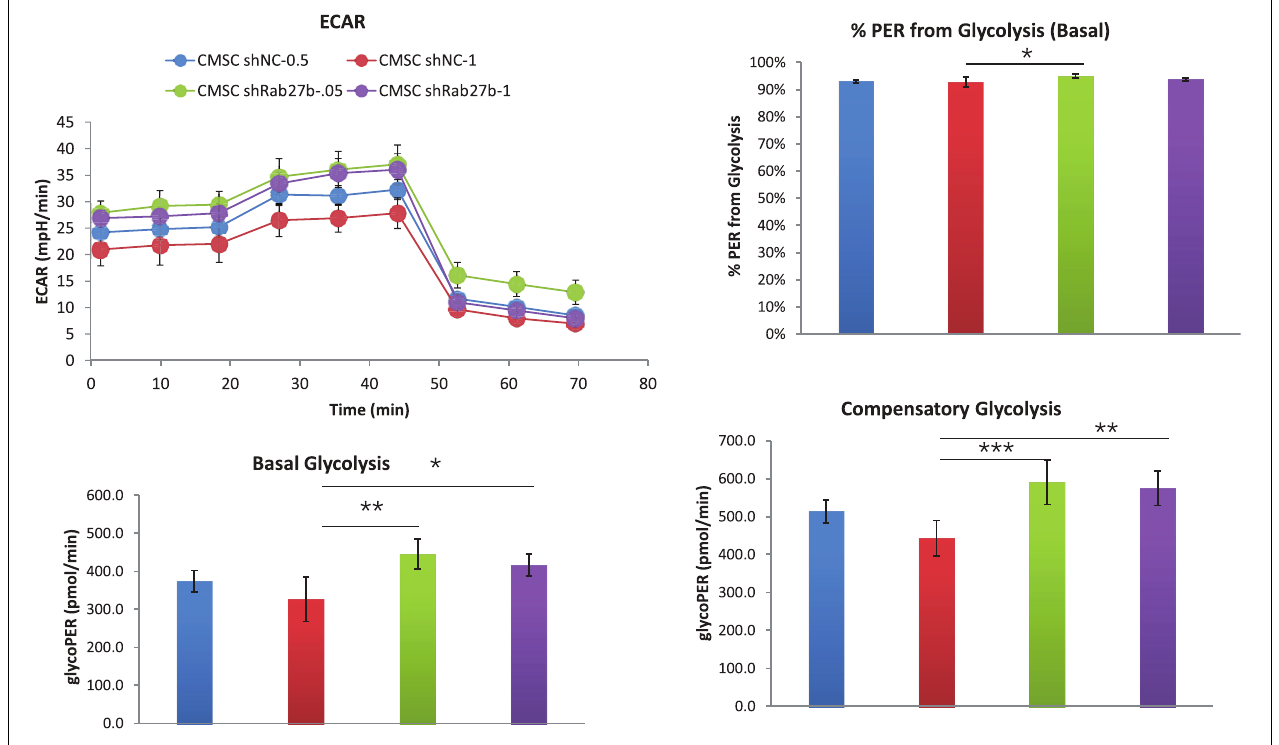
FIGURE 5 | Assessment of extracellular acidification rate (ECAR) in C-MSC sh − NC and C-MSC sh − Rab27b . Cells were exposed sequentially to 0.5 or 1 µ M rotenone/antimycin A and 2-DG. Extracellular acidification rate (ECAR) was measured over time using a Seahorse XFe24 Analyzer. Measurements of basal glycolysis,% PER from glycolysis and compensatory glycolysis were calculated from the ECAR data. Results are presented as mean ± SD (* p < 0.05; ** p < 0.01; *** p < 0.001, n = 5).